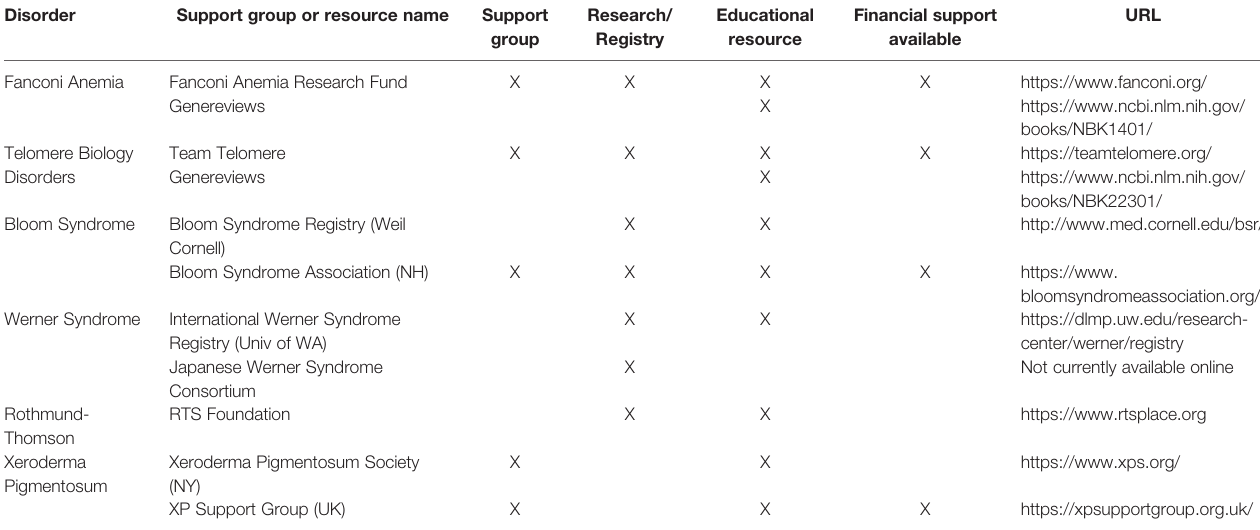
TABLE 3 | Resources for Selected Cancer Predisposition